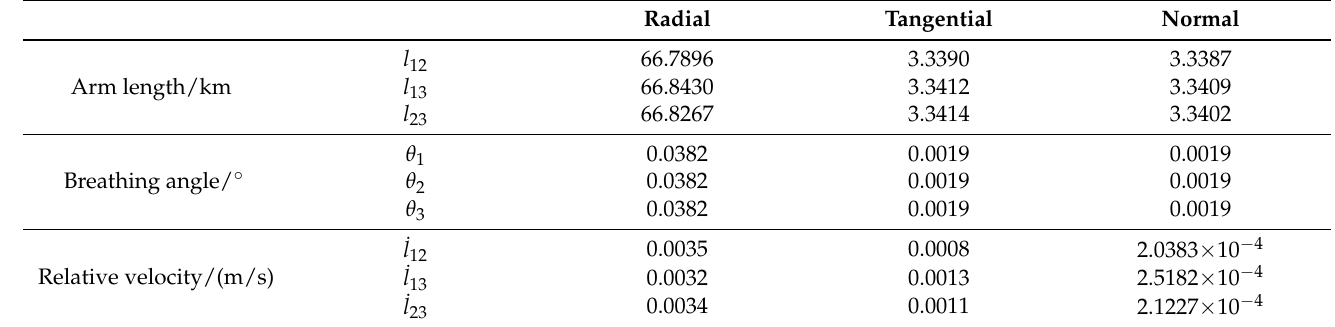
Table 7. STDs of the three stability indexes considering position insertion errors in different